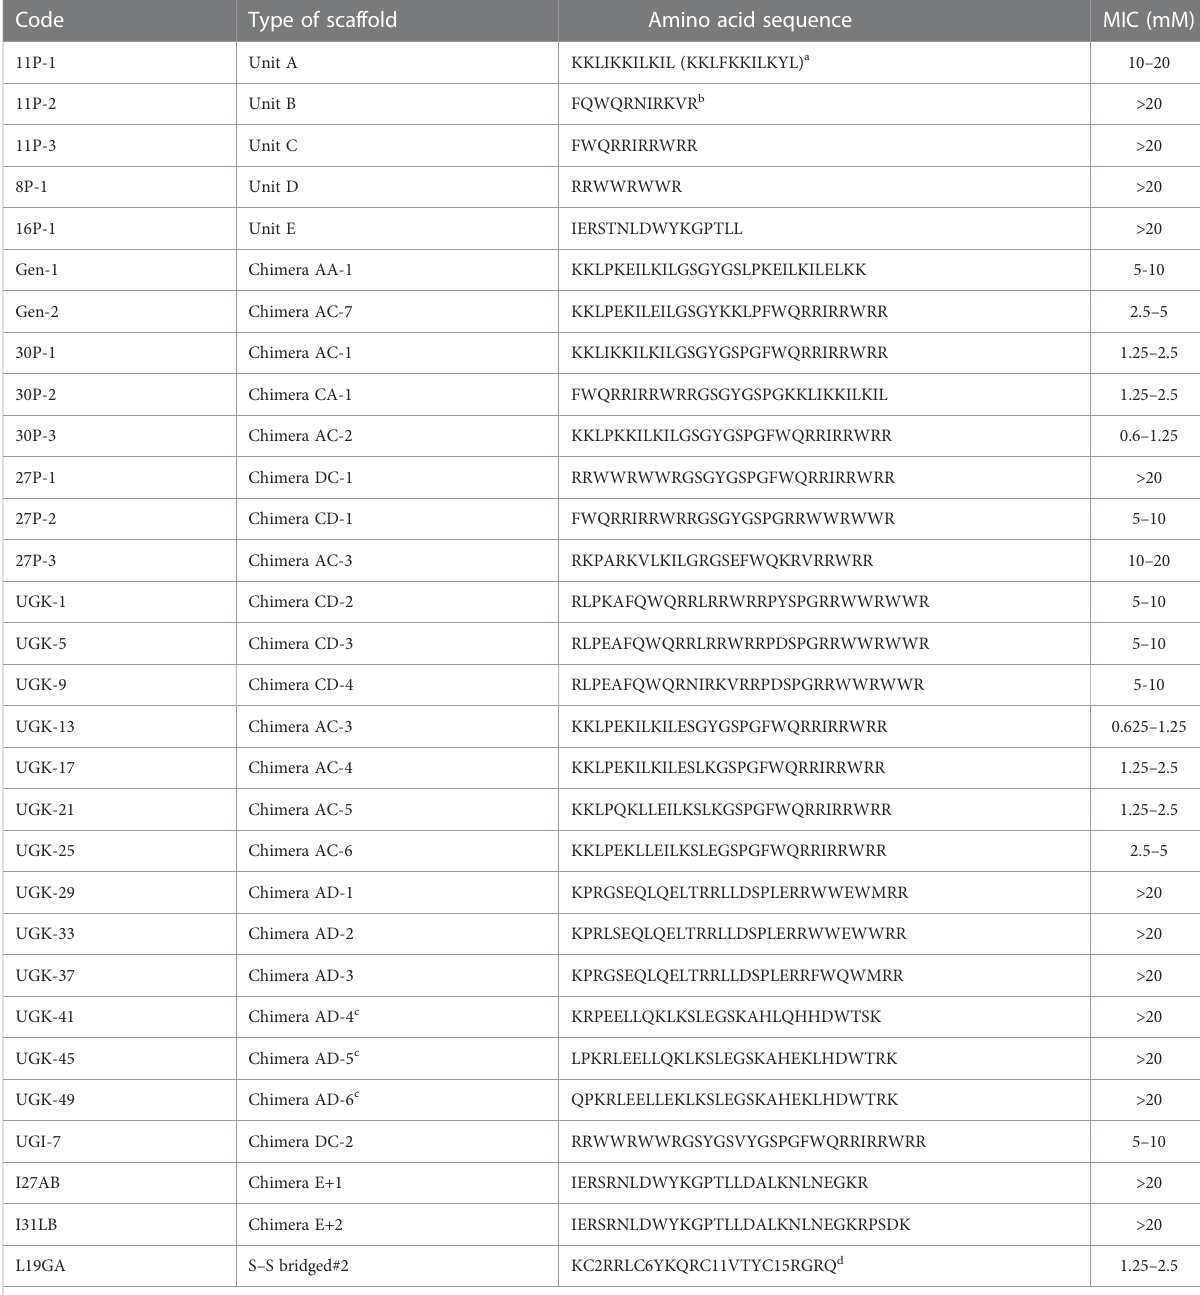
TABLE 1 Minimum inhibitory concentrations (MICs, in micromolars) of the single-unit antibacterial peptides and the chimeras constructed with the single antibacterial units. Code Type of